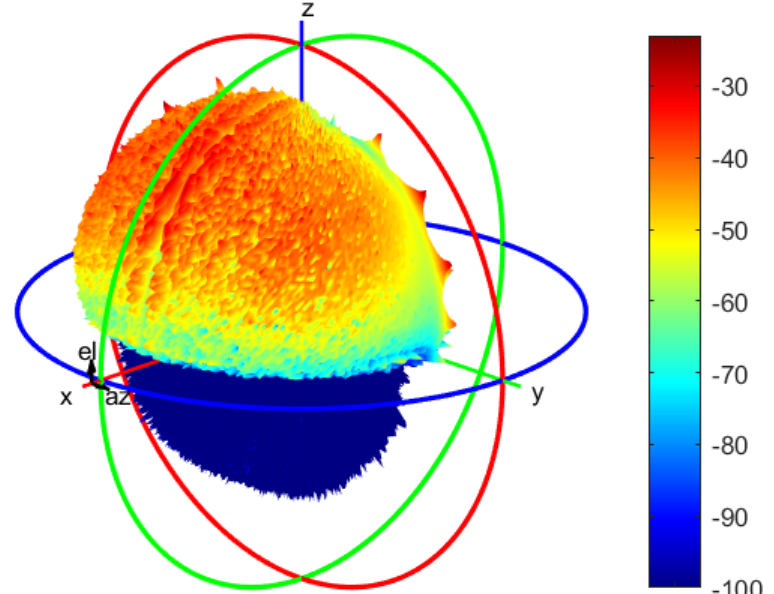
Figure 4. Difference in calculated cross-polarised RCS for the dihedral at 10GHz (units of decibel square